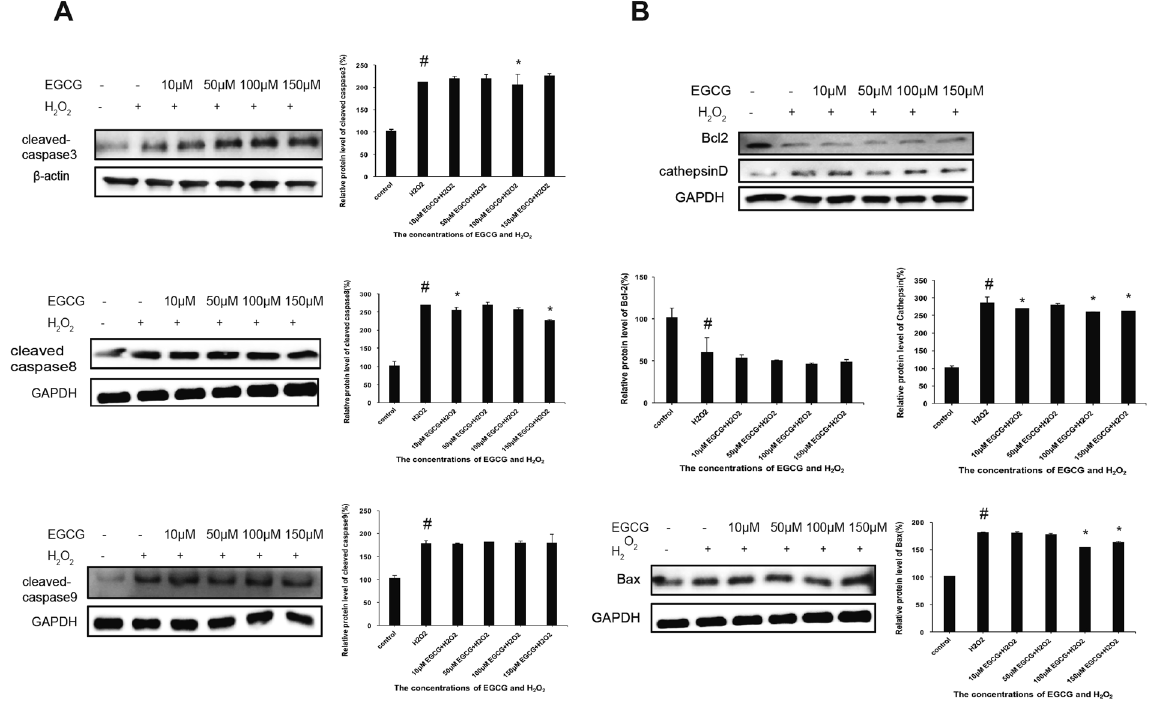
Figure 6. The protective effects of EGCG on H 2 O 2 -induced apoptosis following shRNA silencing of 67LR. ( A ) Western blot analysis showing the expression levels of caspase-3, caspase-8 and caspase-9 following shRNA silencing of 67LR, and subsequent pretreatment with 10, 50, 100, or 150 μ M EGCG for 2 h, followed by treatment with 200 μ M H 2 O 2 for 30 min. ( B ) Western blot analysis showing the expression levels of Bcl-2, Bax and Cathepsin D following shRNA silencing of 67LR, and subsequent pretreatment with 10, 50, 100, or 150 μ M EGCG for 2 h, followed by treatment with 200 μ M H 2 O 2 for 30 min. β -actin and GAPDH were used as internal controls. Results were expressed as Mean ± S.D. from 5 independent experiments. * P < 0.05 vs. H 2 O 2 treatment group, # p < 0.05 vs. control